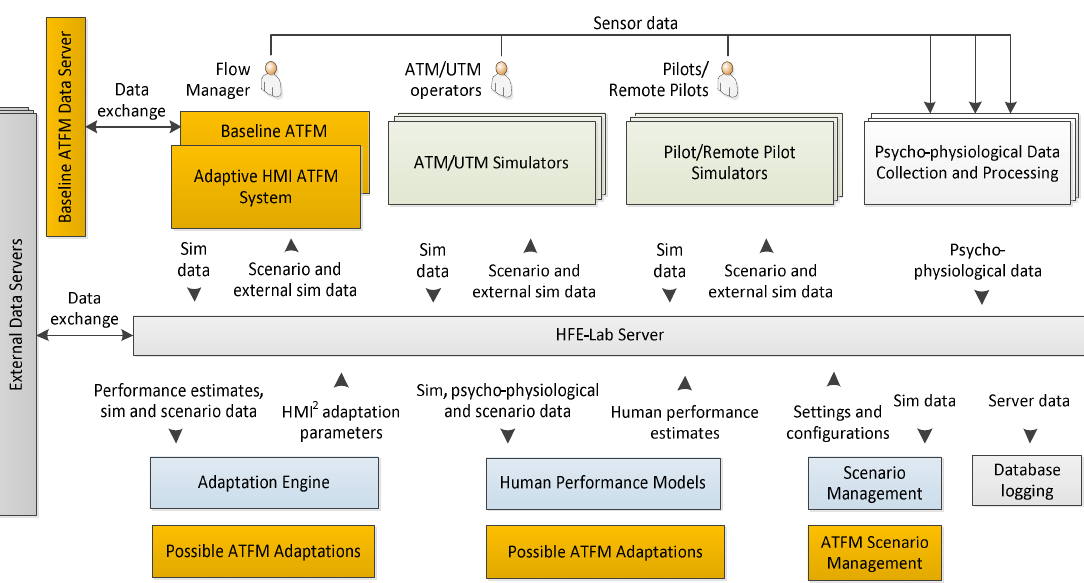
Table 5. Metrics of explanation quality [26].